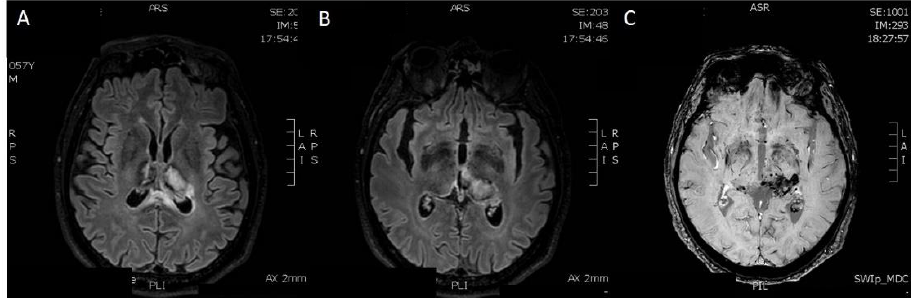
Figure 6. Five months later, he underwent a brain MRI exam. ( A , B ) Axial FLAIR-weighted se- quences show reduction in the diameter of haemorrhagic focus and reduction in perilesional oedema in both thalami. ( C ) In the Susceptibility-Weighted Images, old hematic deposits can be found in both thalami, particularly on the left. Therefore, the exam showed a tendency to encephalomalacic transformation of the ischemic regions and improved sinus rectum patency, with some wall irregularities. The patient continued treatment with Enoxaparin.